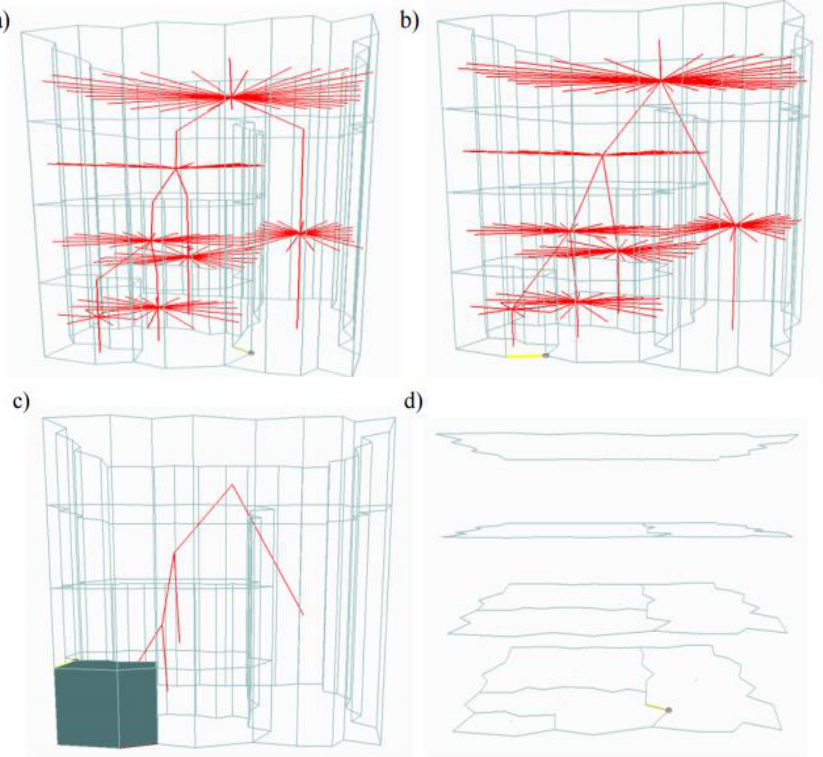
Fig. 13. Overall process of generalization; a) extrusion technique, b) Merge by Face operator, c) Simplified version of the dual (for navigation and query across scale level), d) corresponding 2D maps with different